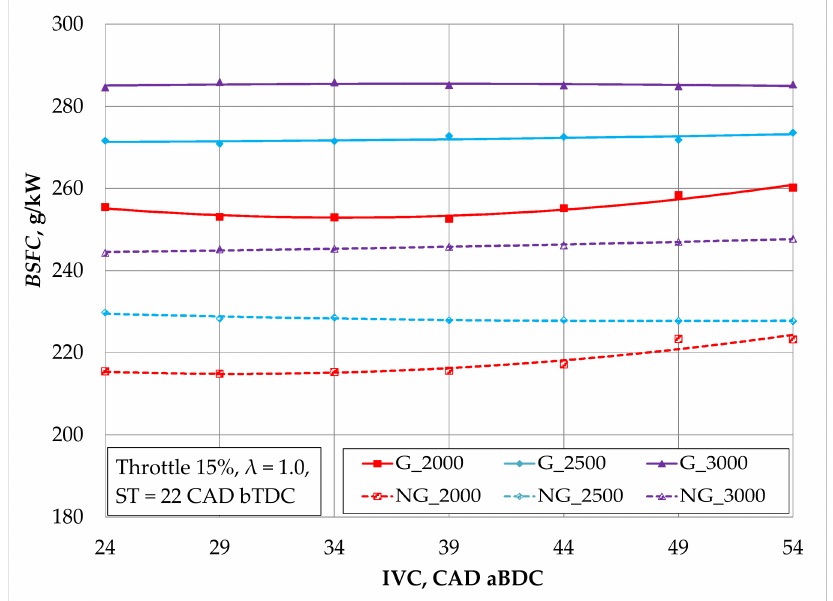
Figure 7. Brake-specific fuel consumption when the engine was running on gasoline and natural gas and while changing the intake valve close